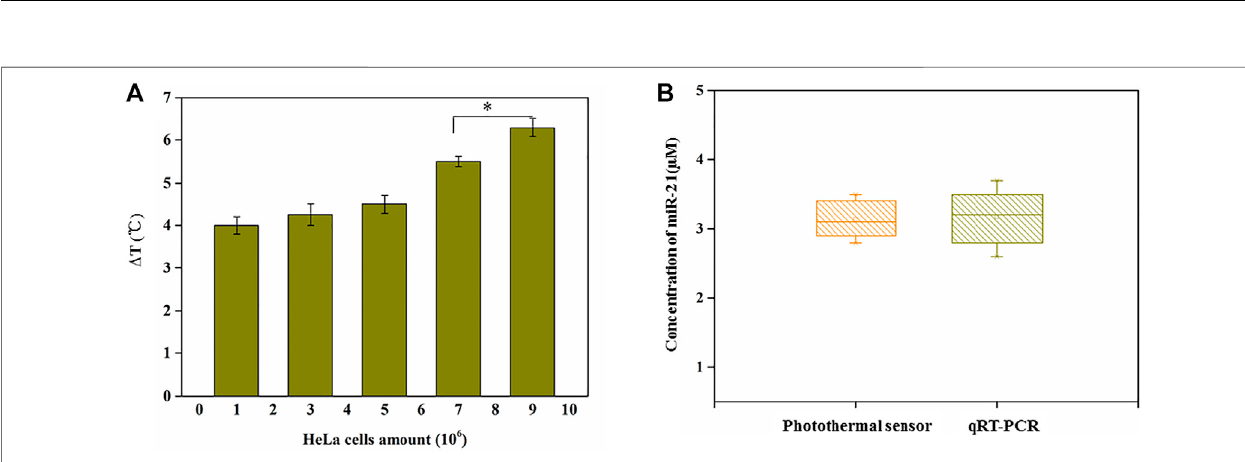
Frontiers in Bioengineering and Biotechnology |